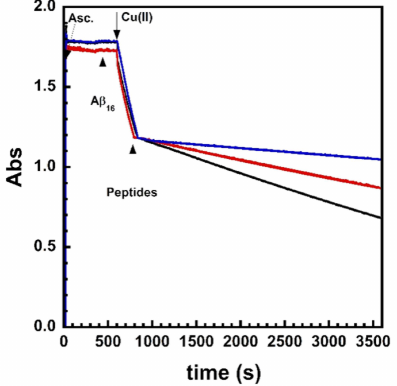
Figure 2. Ascorbate consumption (measured at λ = 265 nm) as a function of time. Ascorbate was added first, followed by by A β 1–16 after 6 min and Cu II after 10 min, and, finally, the AHH peptides at three pH values: 6.8 (black), 7.5 (red), and 8.2 (blue), when an absorbance of 1.2 was reached. Measurements were performed in 50 mM HEPES buffer (pH 7.5) at 25 ◦ C with continuous stirring. Final concentrations: [Asc] = 100 µ M, [AHH] = 12 µ M, Cu II = 10 µ